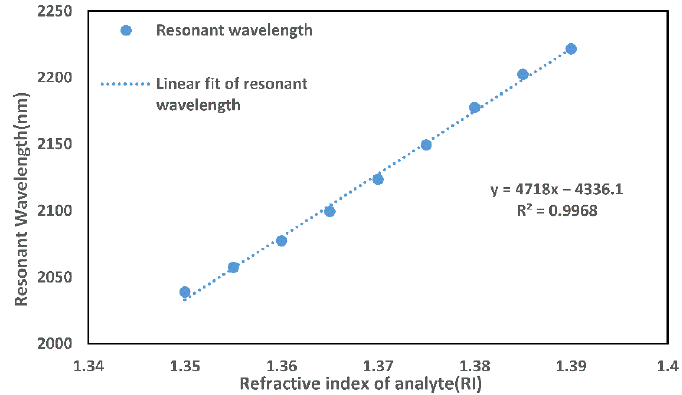
Figure 8. Fitting curve of resonance wavelength with RI.